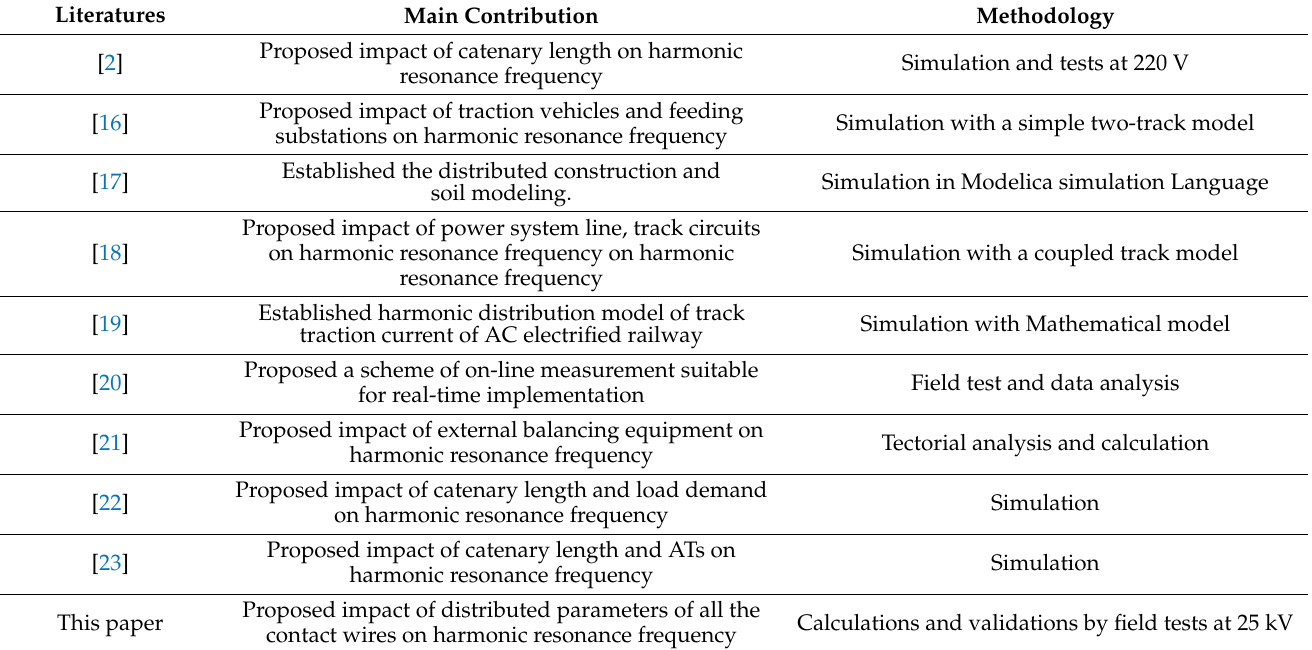
Table 1. Comparison with other